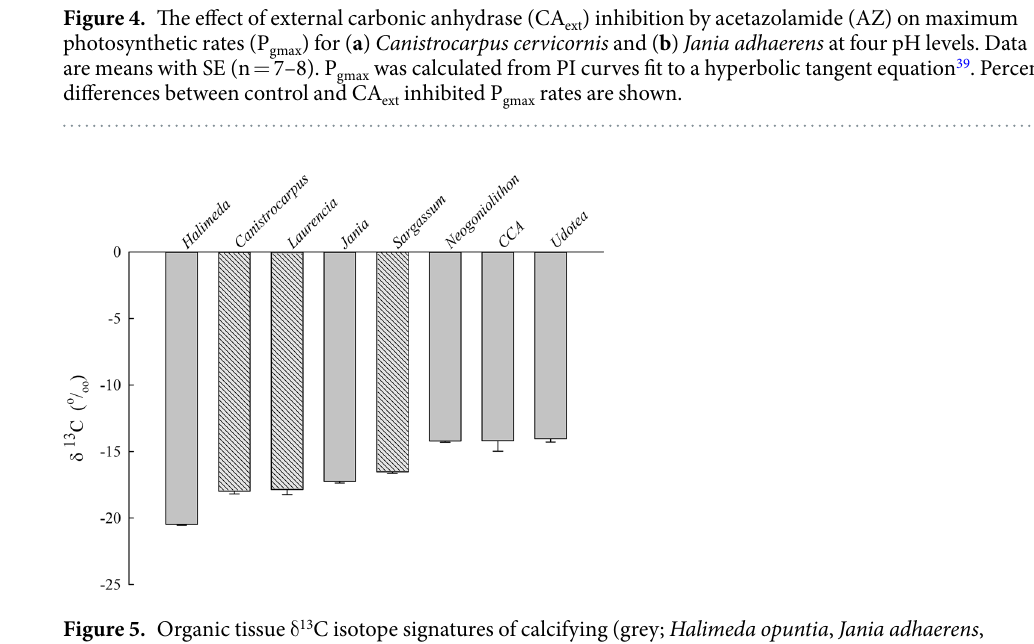
Figure 5. Organic tissue δ 13 C isotope signatures of calcifying (grey; Halimeda opuntia , Jania adhaerens , Neogoniolithon strictum , CCA, Udotea luna ) and fleshy (striped; Canistrocarpus cervicornis , Laurencia intricata , Sargassum fluitans ) macroalgae used in this study collected from a patch reef site on the Florida Keys reef